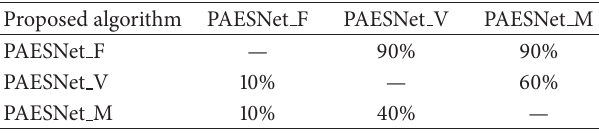
Table 2: Win rates for training results across all 10 runs. Proposed algorithm PAESNet F